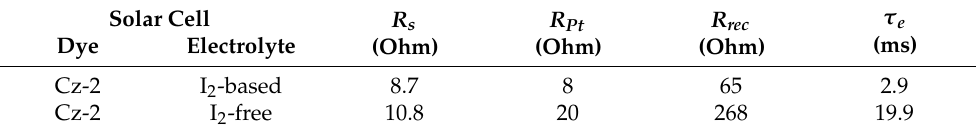
Table 3. Parameters obtained from the electrochemical impedance spectroscopy (EIS) measurements for the solar cells that employed the working electrodes that were sensitized by the Cz-2 dye, using the I 2 -based or I 2 -free